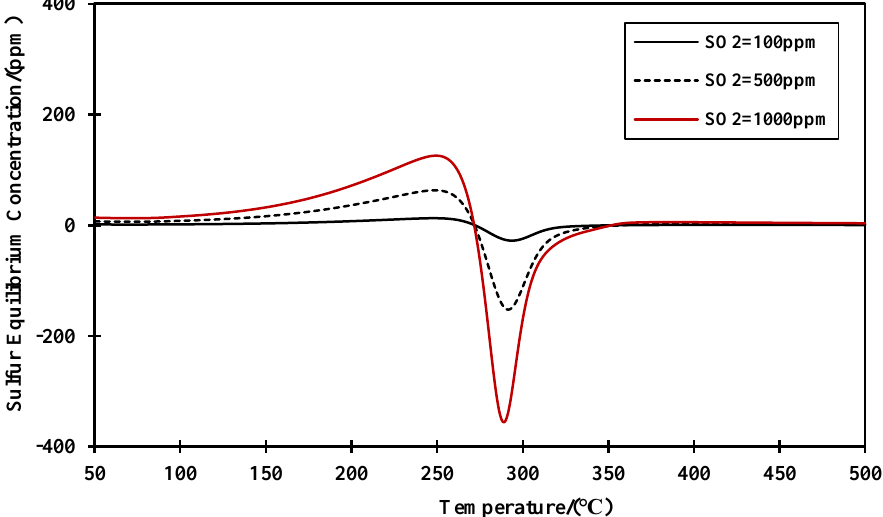
Figure 11. The relationship between the sulfur equilibrium concentration and the temperature at different SO 2 concentrations (O 2 :16%, H 2 O: 3%).